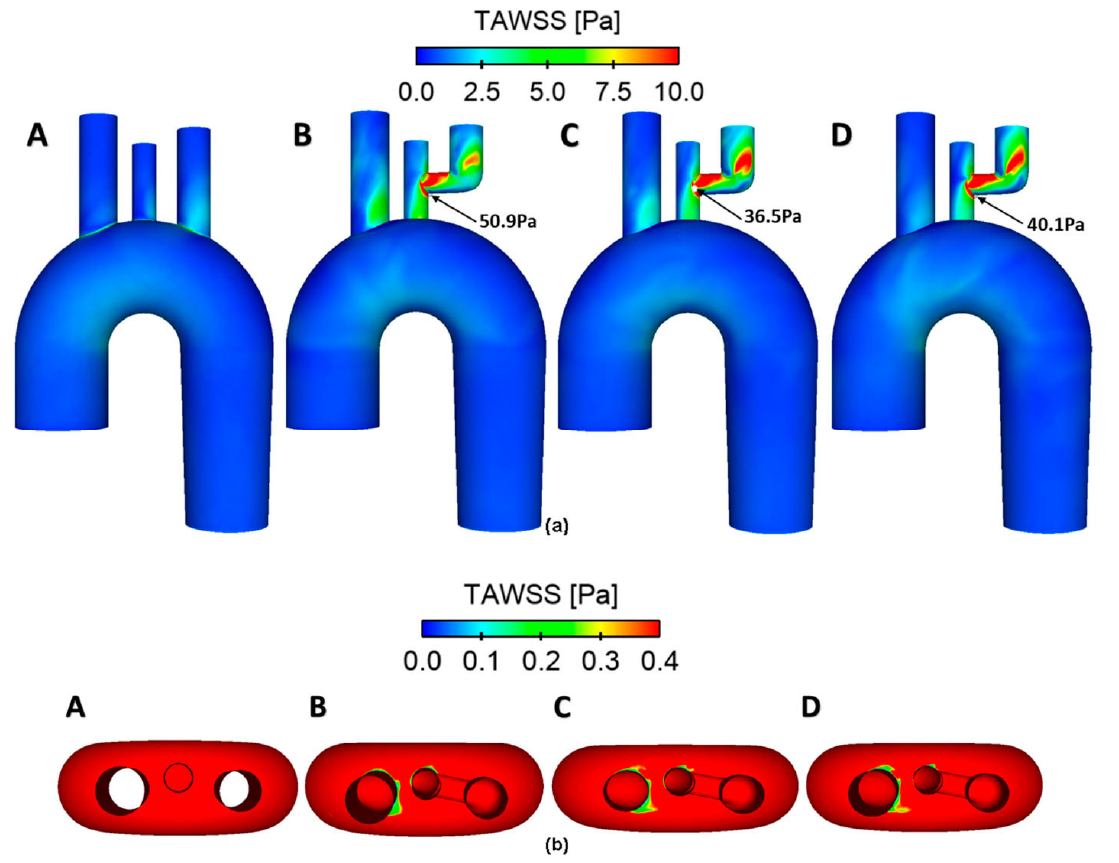
Figure 6. Comparison of TAWSS in the four models: ( A ) non-stented aortic arch (reference case), ( B ) stent-graft 1, ( C ) stent-graft 2, and ( D ) stent-graft 3. TAWSS distributions are displayed in different views to identify areas with ( a ) very high (>10 Pa) and ( b ) very low (<0.4 Pa) values. The maximum TAWSS on the walls of all stented geometries are highlighted by the black arrows.